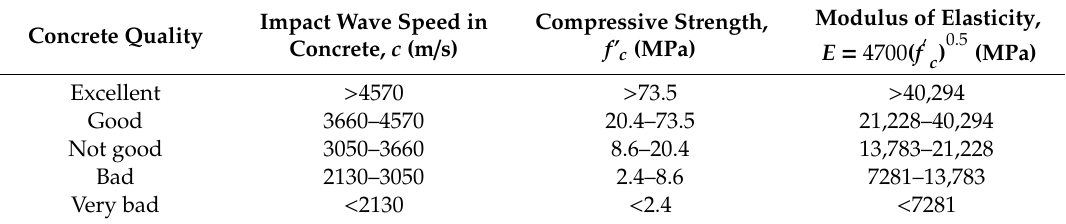
Table 1. The relation between concrete quality and impact wave velocity [24], compressive strength [25], and modulus of elasticity